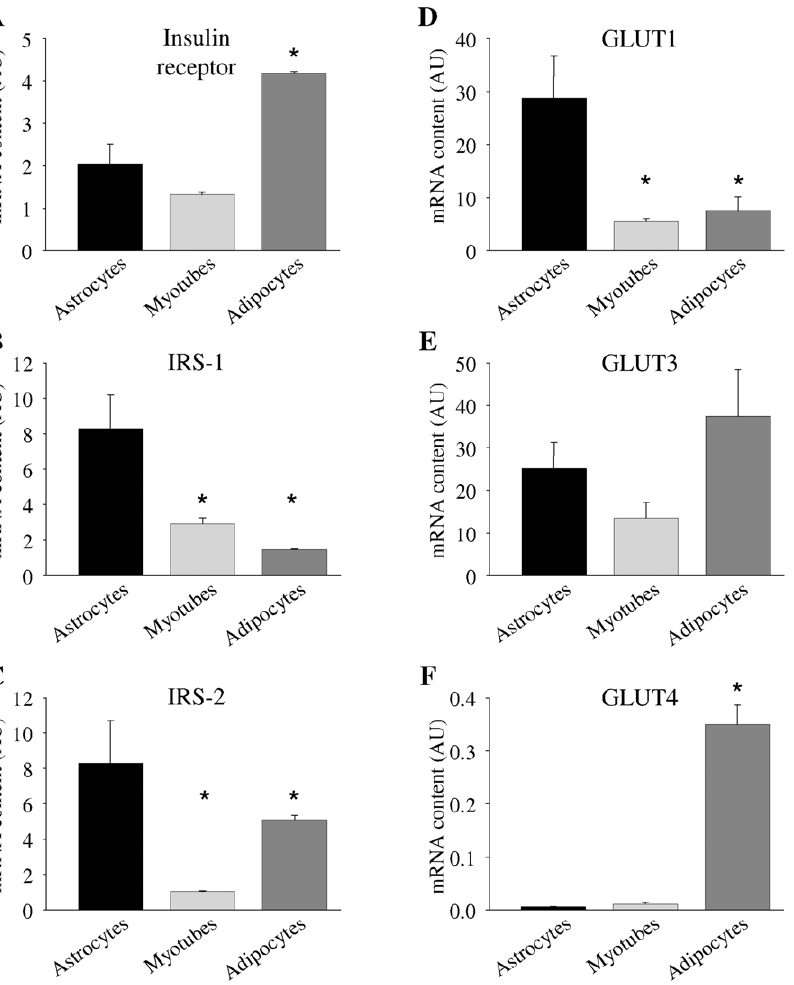
Figure 1. mRNA expression in human astrocytes (black bars) in comparison to human myotubes (light grey bars) and human adipocytes (dark grey bars). ( A ) Insulin receptor, ( B ) IRS-1, ( C ) IRS-2, ( D ) GLUT1, ( E ) GLUT3, ( F ) GLUT4. mRNA expression was normalized for mRNA of the housekeeping gene Rps13 . Bars represent means + SEM. N=3. There were significant differences between the groups in all mRNA expressions analyzed (ANOVA, all p # 0.0254) except for GLUT3 mRNA (ANOVA, p=0.2). * indicates significant difference from astrocytes (Tukey Kramer post hoc test p , 0.05).